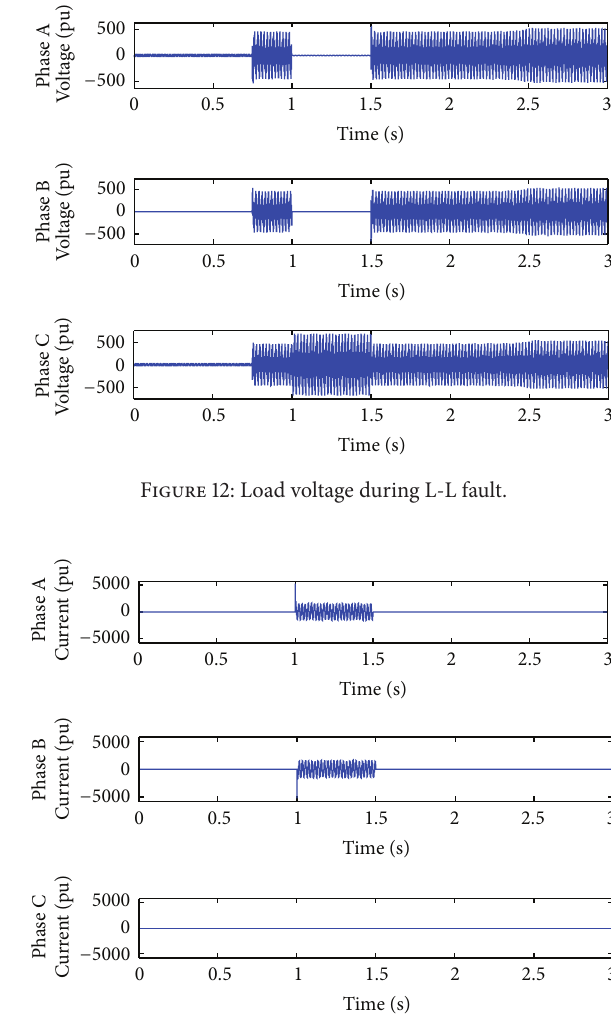
Figure 13: Load current during L-L